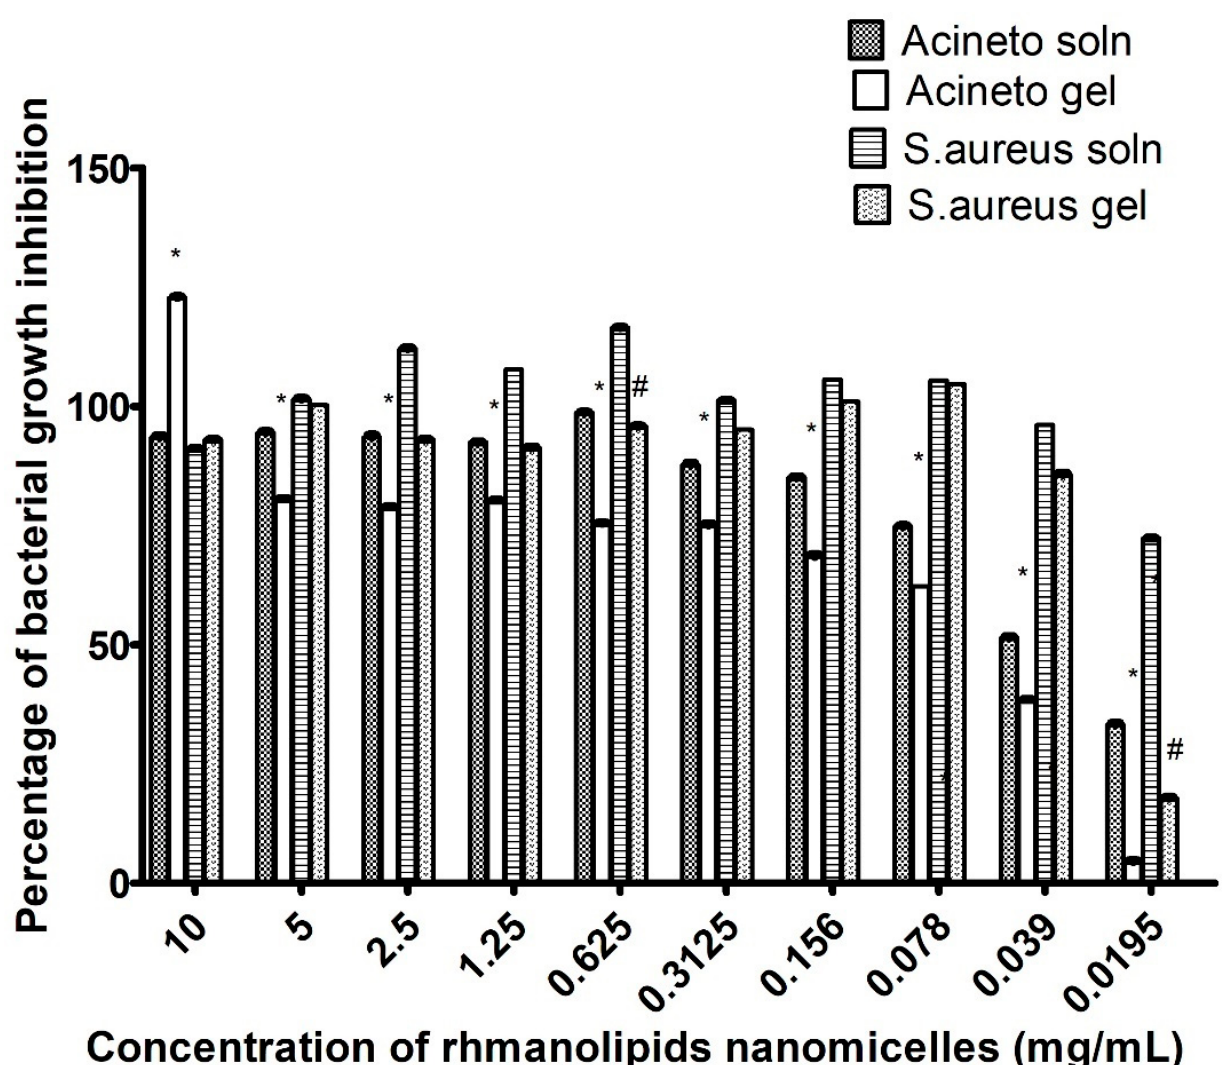
Figure 2. Percentage of bacterial growth inhibition of A. baumannii and S. aureus recorded by microdilution assay at different concentrations of rhamnolipid nano-micelles formulations (solution and gel). Data are expressed as the mean ± SD. Data were analyzed by two-way ANOVA followed by Bonferroni’s test for multiple comparisons. Significant differences in the antibacterial potency of the rhamnolipid nano-micelles formulations (solution and gel) against A. baumannii and S. aureus are denoted by * and # at p < 0.05, respectively.